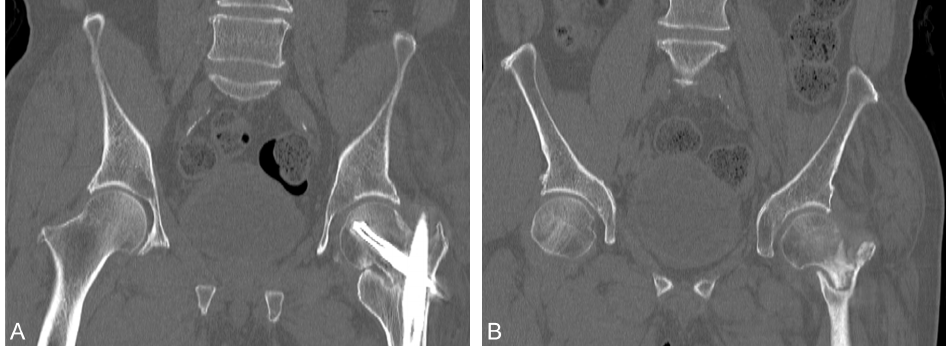
Figure 4. ( A , B ) CT performed at 9 months postoperatively. Fracture gap was still evident.